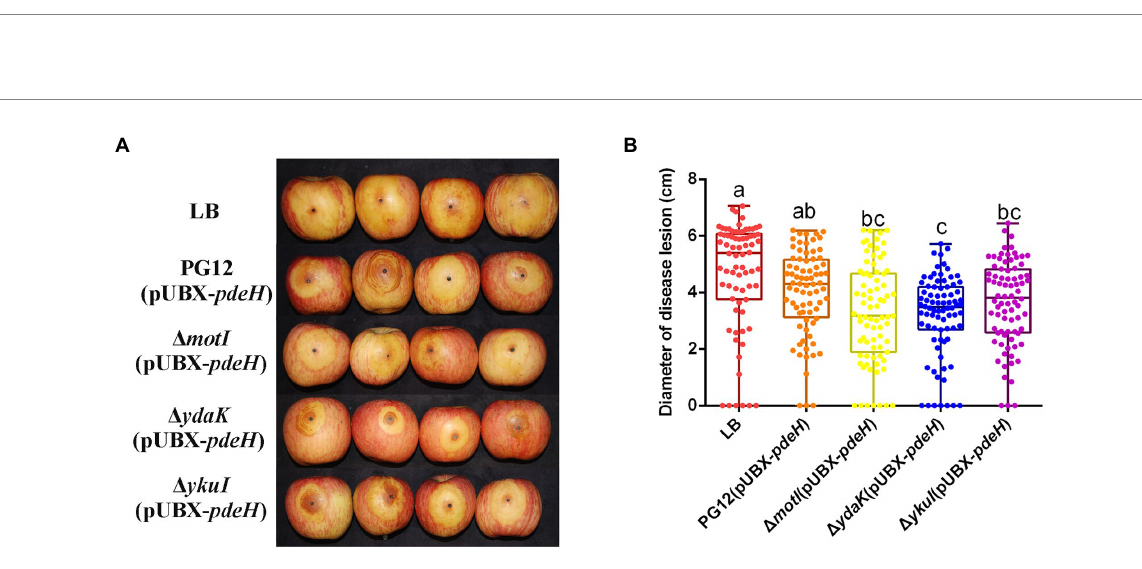
FIGURE 8 Effect of the potential c-di-GMP receptors on biocontrol efficacy against apple ring rot disease in low c-di-GMP background. Bacteria were incubated for 48 h in LB broth supplemented with 1% (w/v) xylose at the final concentration. Biocontrol efficacy was assessed with Fuji apple fruits treated with the cultures of B. velezensis PG12(pUBX- pdeH ) [PG12(pUBX- pdeH )], Δ motI (pUBX- pdeH ), Δ ydaK (pUBX- pdeH ), or Δ ykuI (pUBX- pdeH ). LB broth (LB) was used as control. Images were taken (A) and the diameter of disease lesions (B) was measured 7 days post inoculation. Values correspond to the mean diameter of 80 disease lesions from 20 apple fruits. The data is a representative of three independent experiments. Different letters on the column indicate significant differences between different treatments according to the least significant difference (LSD) test ( p <